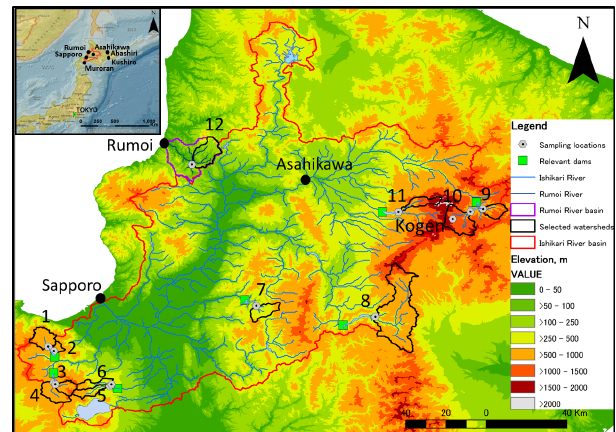
Figure 2. Location of the Hokkaido study area with the sampling points in the selected watersheds shown by